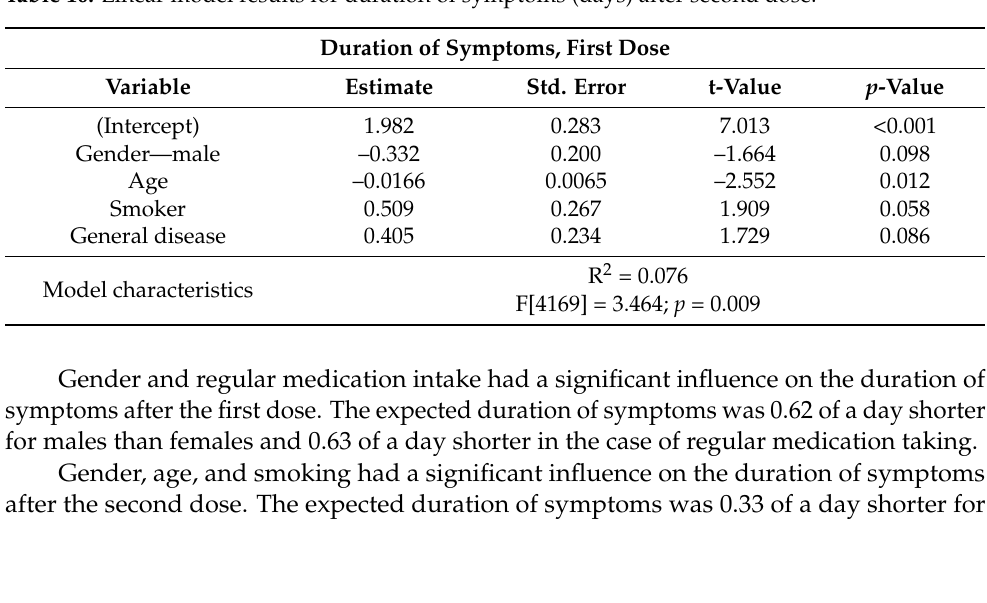
Table 10. Linear model results for duration of symptoms (days) after second